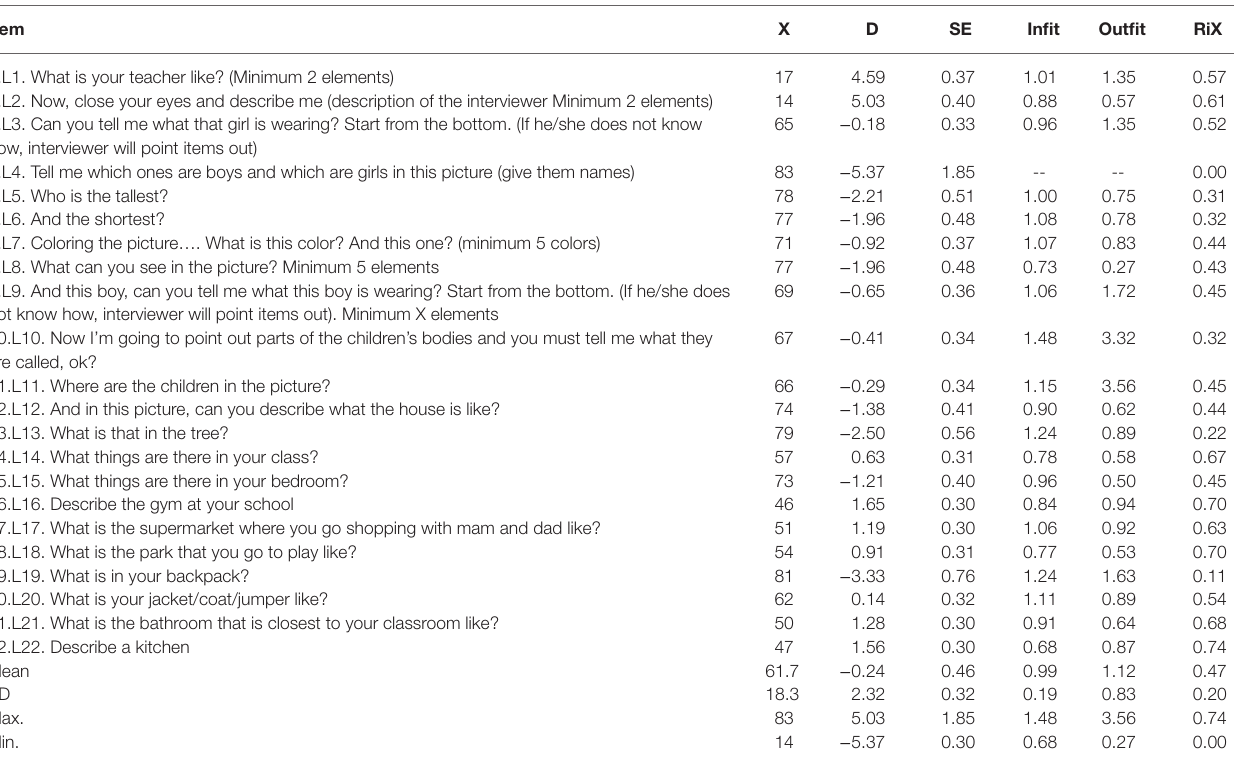
TABLE 2 | CAPALIST-language. Item